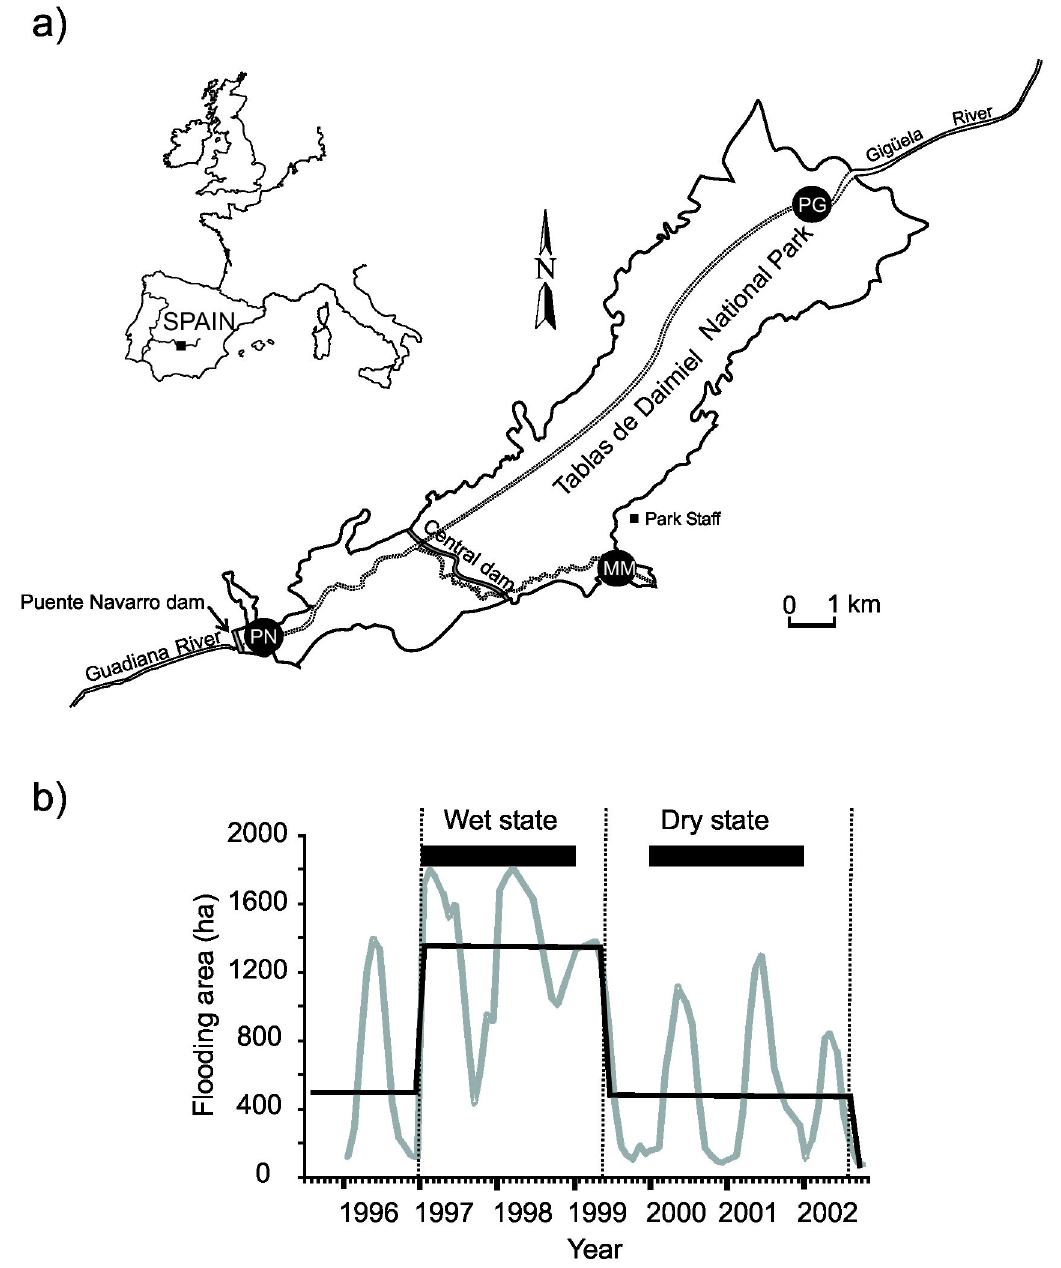
Figure 1. Location of the Las Tablas de Daimiel floodplain wetland, a National Park in central Spain (a), and clearly discernable hydrological states, revealed by regime shift detection (b). Shown are the patterns of flooded area (grey line) between 1996 and 2003, state transitions (black line), and the periods covered for analyses of phytoplankton community structure (horizontal black bars) in the wet and dry